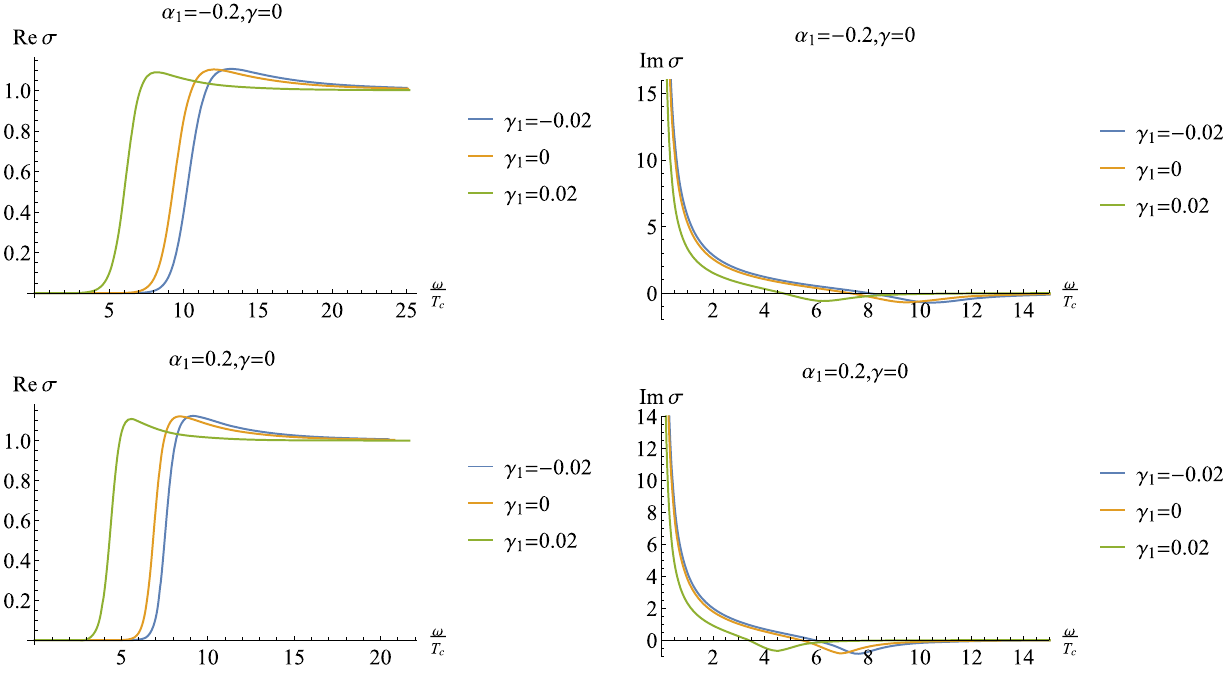
Fig. 12 Real and imaginary parts of conductivity as a function of the frequency for different γ 1 Table 3 The superconducting energy gap ω g / T c with different α